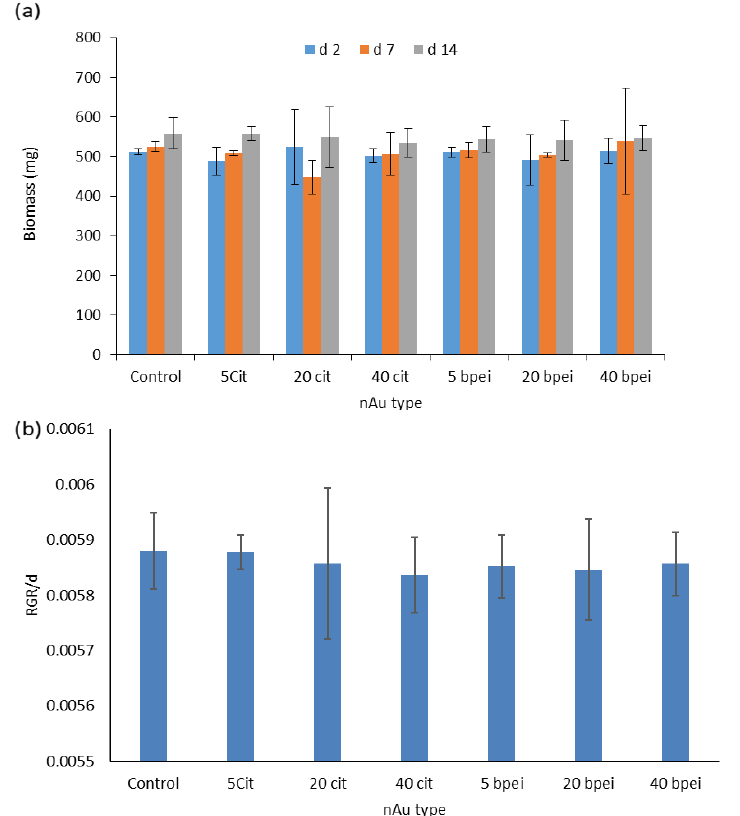
Figure 3. Plant growth for untreated and gold NPs-treated plants in 10% Hoagland’s medium over 14 d ( a ) fresh biomass (mg), ( b ) relative growth rate (RGR) per day. Results are reported as mean ± SD ( n = 3), and bars denote standard deviations (SD). Using one-way ANOVA, no significant differences were observed between the controls and nAu-exposed samples over 14 d ( p > 0.05), irrespective of endpoint.